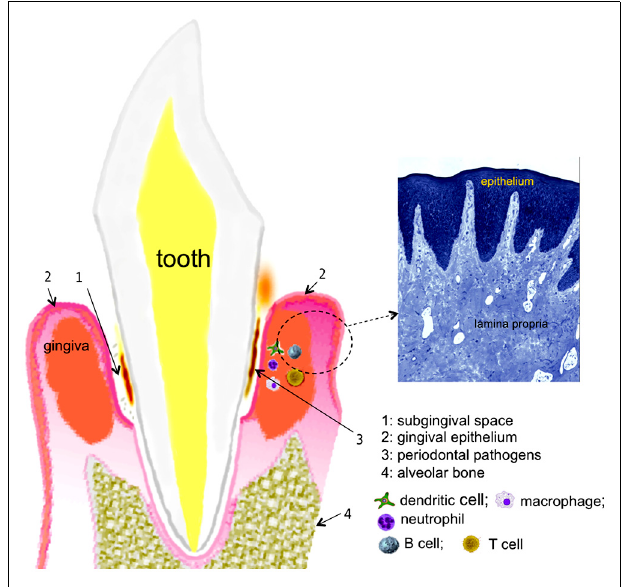
FIGURE 1 | Schematic representation of the periodontal tissues supporting the tooth. A histological section of the gingival tissue stained with toluidine blue is shown on the right (courtesy, Dr. Moon-Il Cho, University at Buffalo).